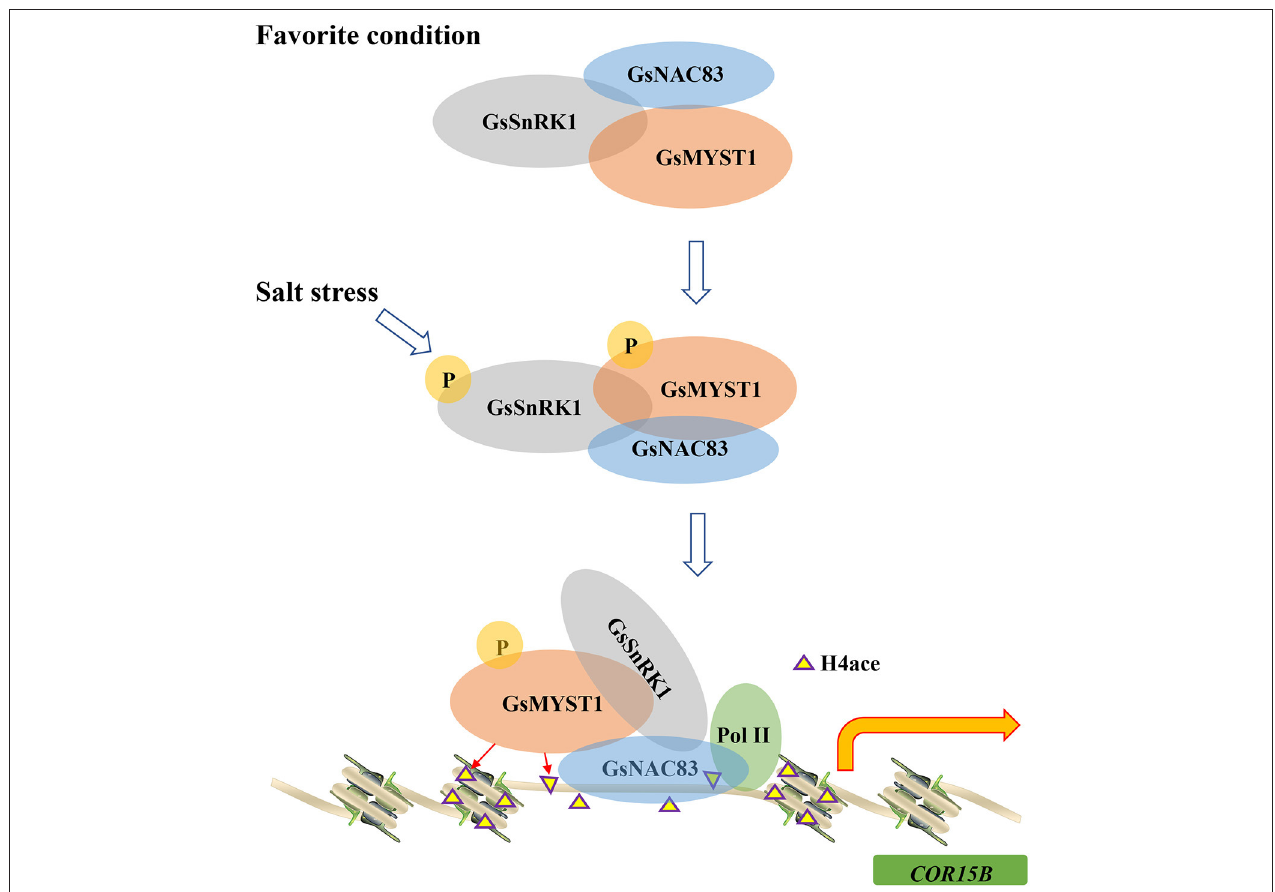
FIGURE 9 | A model of GsSnRK1-GsMYST1-GsNAC83 regulating soybean response to salt stress. Under the favorite condition, GsSnRK1, GsMYST1, and GsNAC83 interact with each other to form a ternary complex. On salt stress from the environment, the upstream kinase (e.g., GRIK1) phosphorylates Thr176 to activate GsSnRK1, and the activated GsSnRK1 phosphorylates Ser44 of GsMYST1. The phosphorylated GsSnRK1 and GsMYST1 are recruited to the COR15B gene promoter by the GsNAC83 transcription factor. GsMYST1 acetylates histone H4 to stimulate expression of the COR15B gene to enhance plant resistance to salt